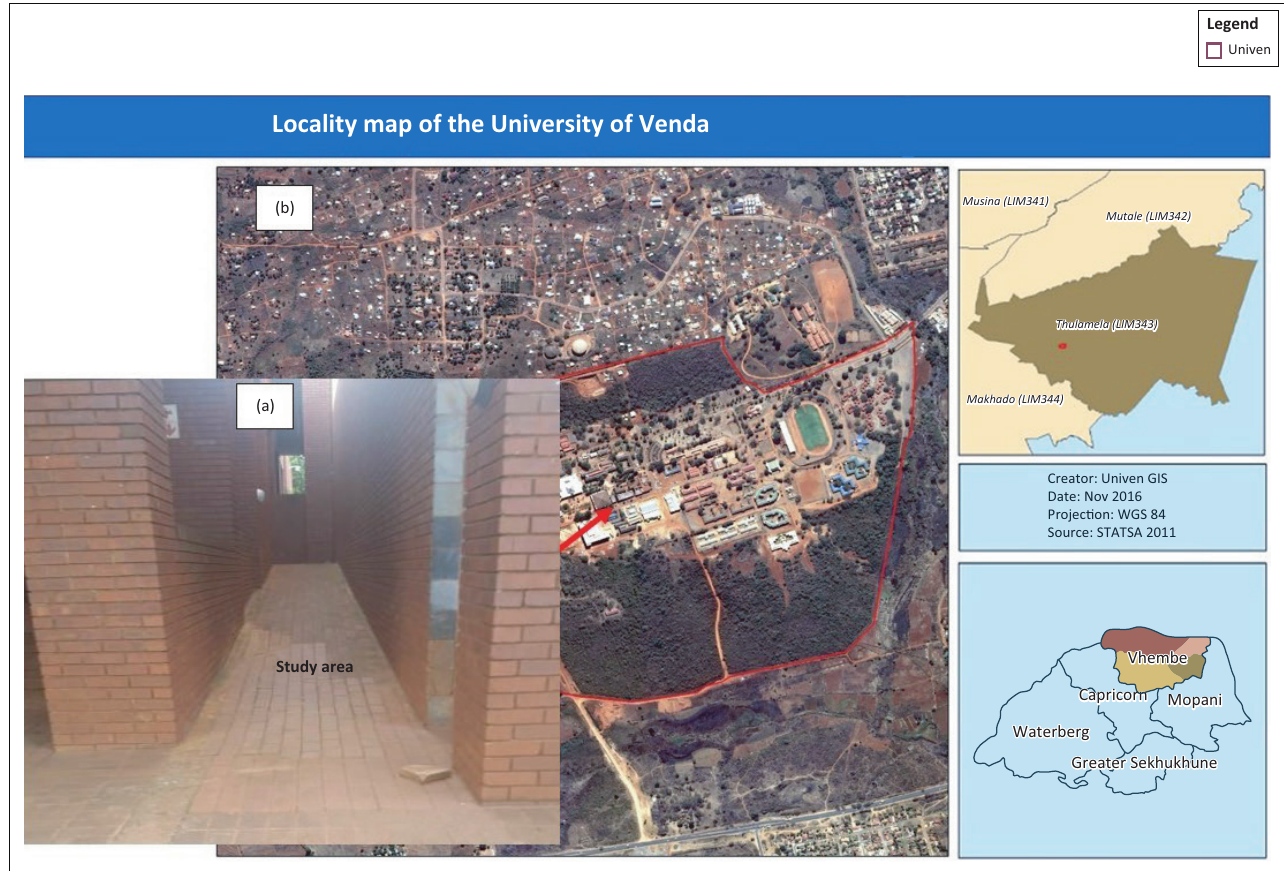
FIGURE 2: The location of the pavement at the University of Venda